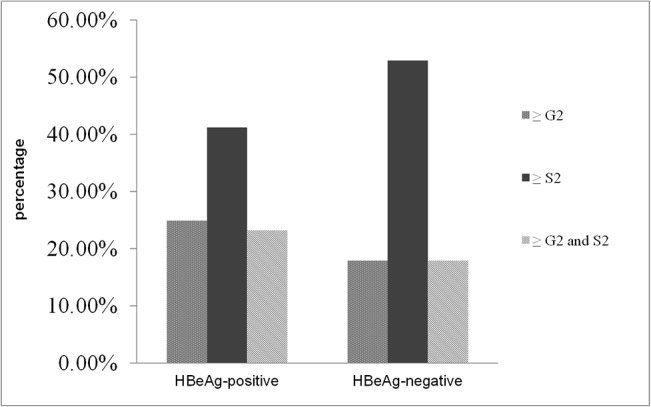
Incidence of necroinflammation ≥ 2, or fibrosis ≥ 2 or a combination of both ≥ G2 and S2.Significant levels of necroinflammation (≥ G2), fibrosis (≥ S2), and necroinflammation (≥ G2) and fibrosis (≥ S2) occurred in 24.9%, 41.2%, and 23.2%, respectively, in HBeAg-positive patients. Significant levels of necroinflammation (≥ G2), fibrosis (≥ S2), and necroinflammation (≥ G2) and fibrosis (≥ S2) were seen in 17.9%, 52.9%, and 17.9%, respectively, of the HBeAg-negative patients.